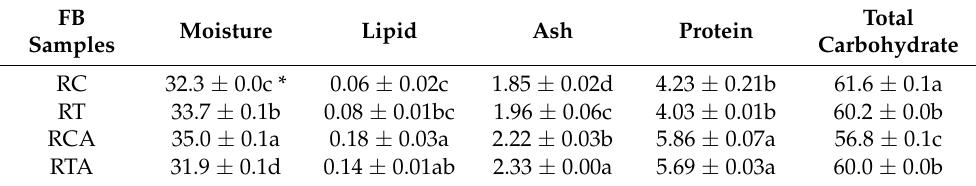
Table 4. Proximate chemical composition of FB samples (g/100 g d.m.). FB